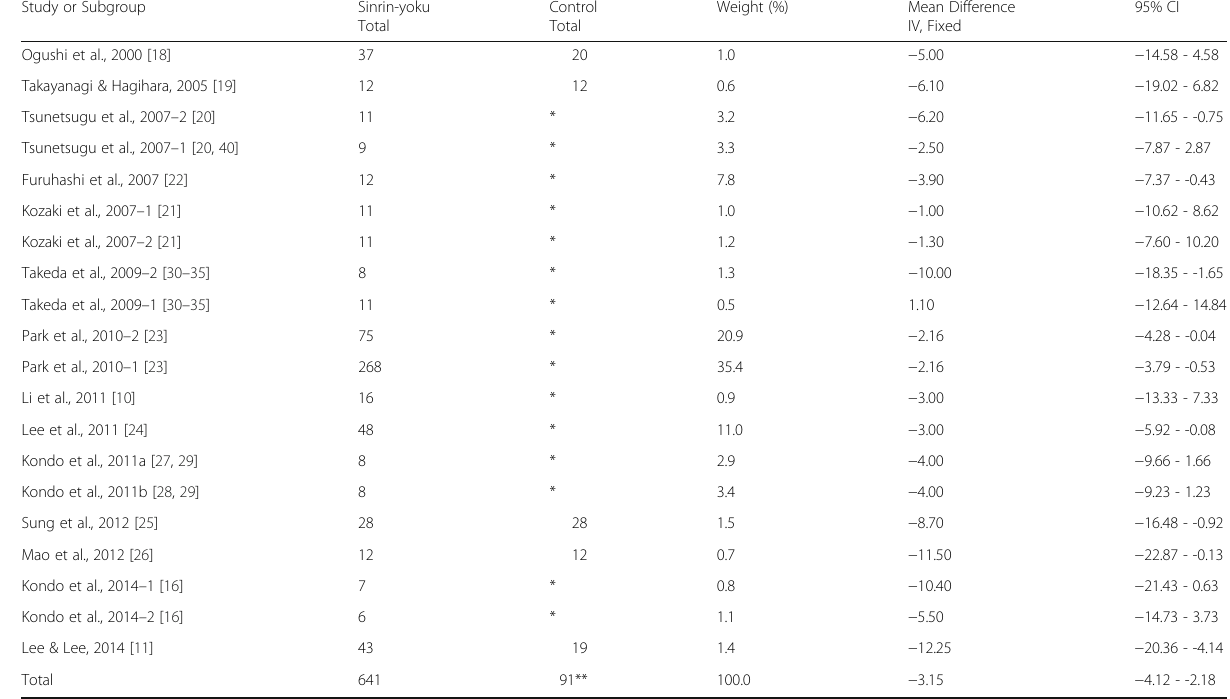
Table 1 Result of the meta-analysis comparing changes in SBP (mmHg) between the forest environment and the non-forest envir- onment based on 20 studies or